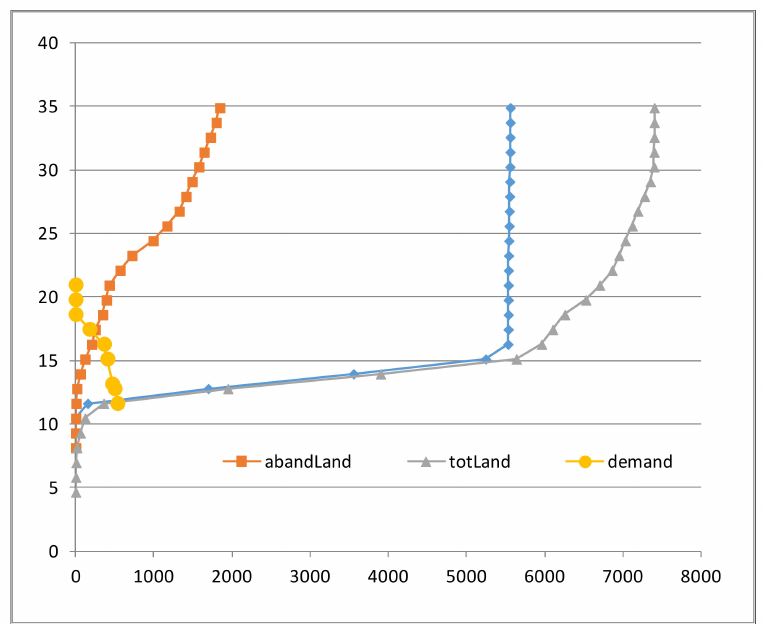
Figure 3. Supply curves of biomass at the NUTS-2 (voivodeship) level (vertical axis in € /t, horizontal axis in kt) composed of crop residues and sorghum on different land types (Utilized Agricultural Area—Abandoned/unutilized Area).